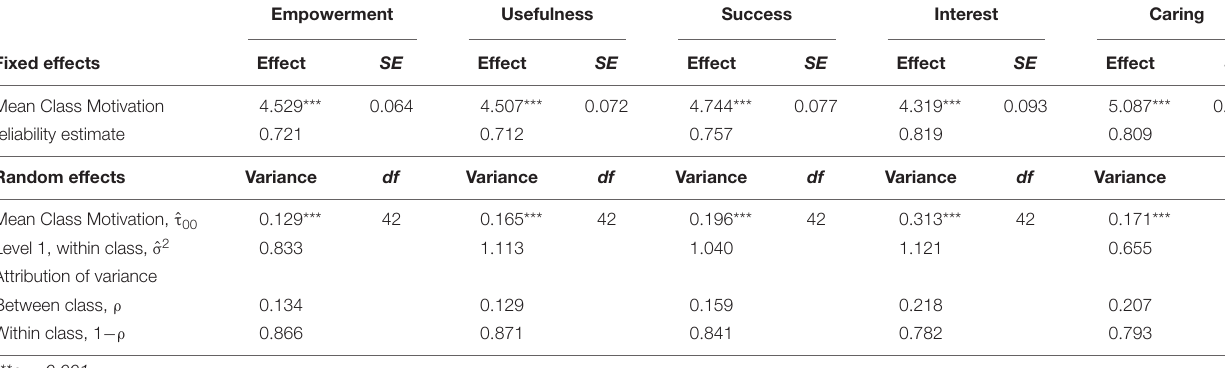
TABLE 5 | Unconditional models for the five components of the MUSIC model of motivation.